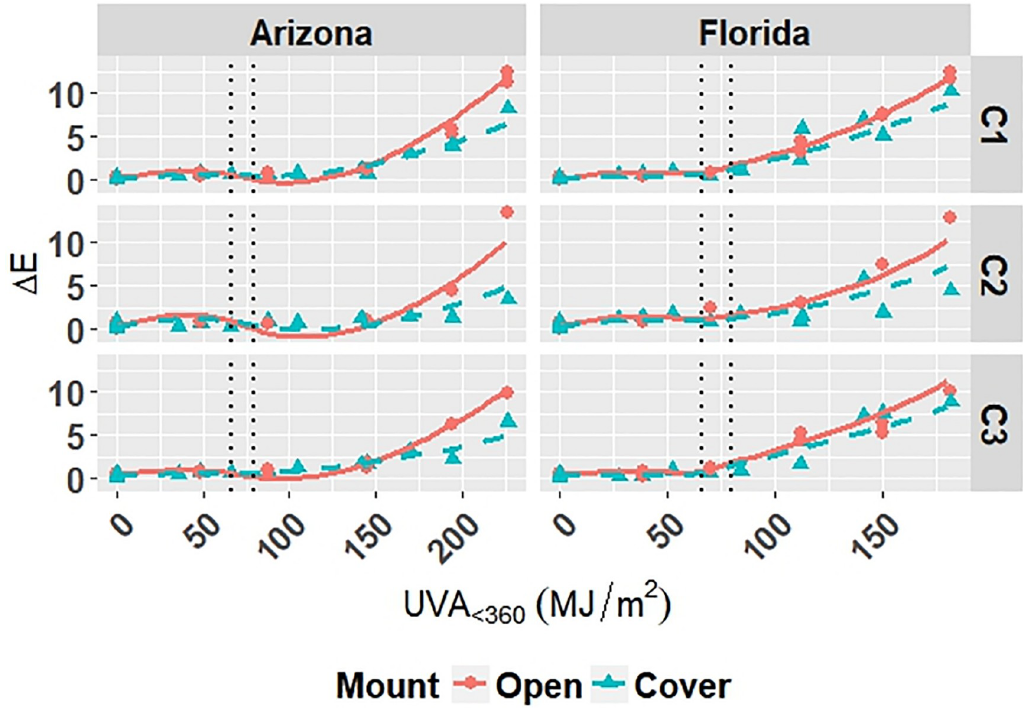
Fig 1. The change in Δ E clear grades of PET under outdoor exposures with the model curves superimposed on the data. Points represent the measured data and dashed lines represent the models. Vertical, dotted lines represent the location of natural spline